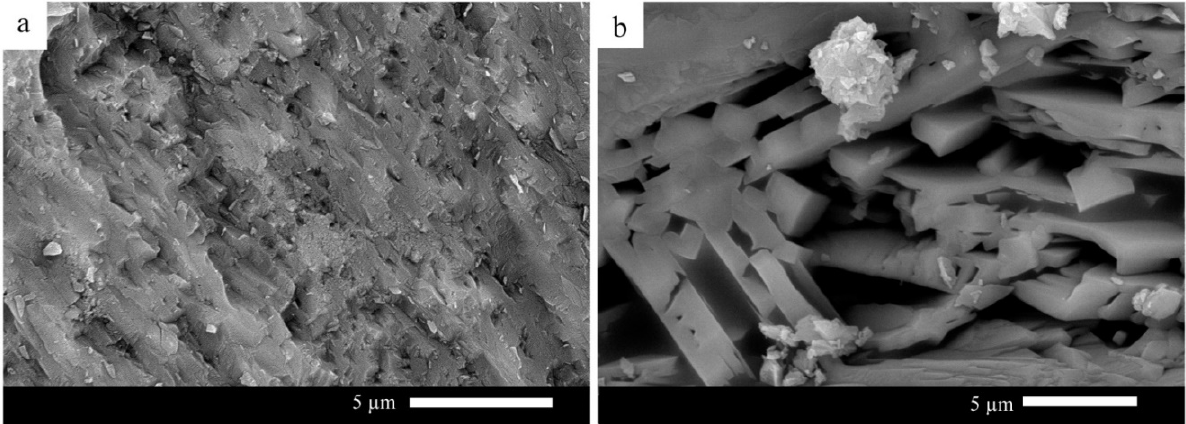
Figure 6. SEM micrographs of G60 heat ‐ treated at ( a ) 700 °C 3 h and 1000 °C 1 h; ( b ) 700 °C 1 h and 1000 °C 1 h.